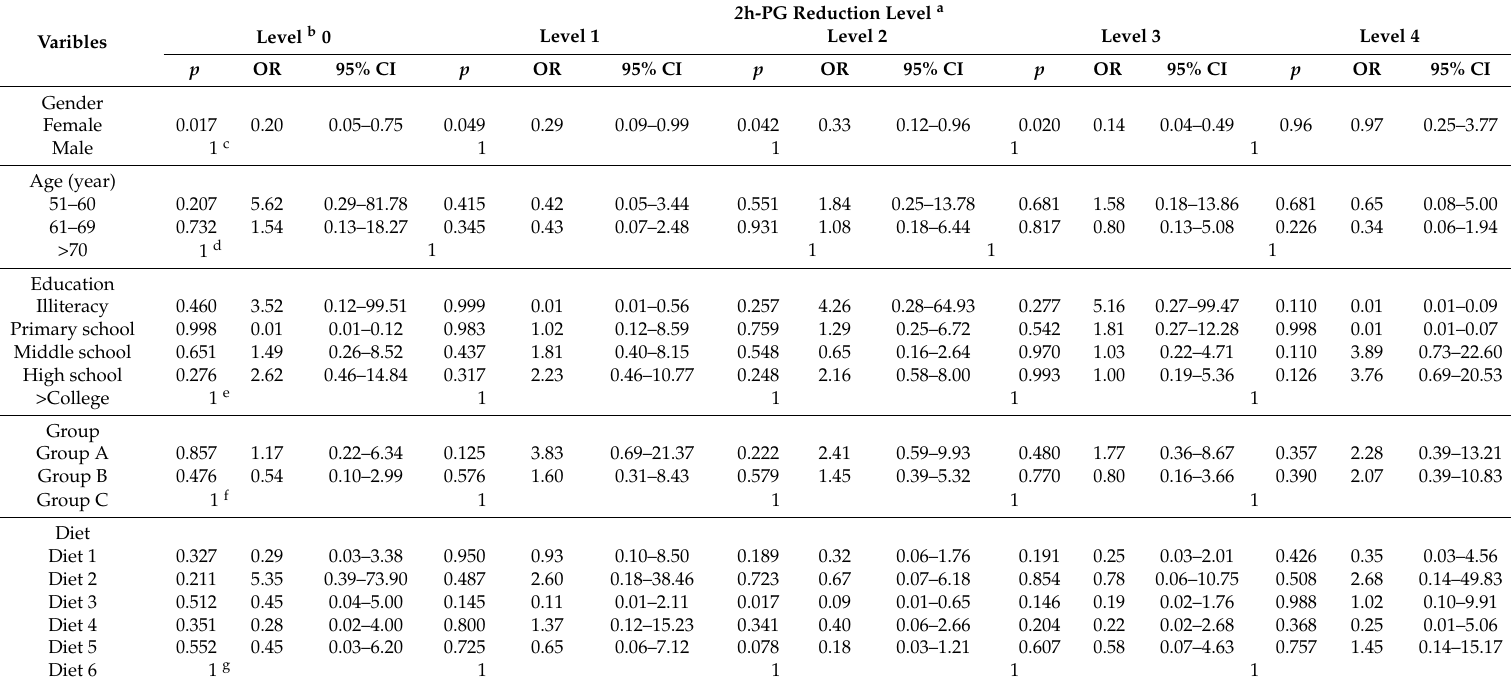
Table 7. Analysis of the associations between 2 h-PG reduction and different